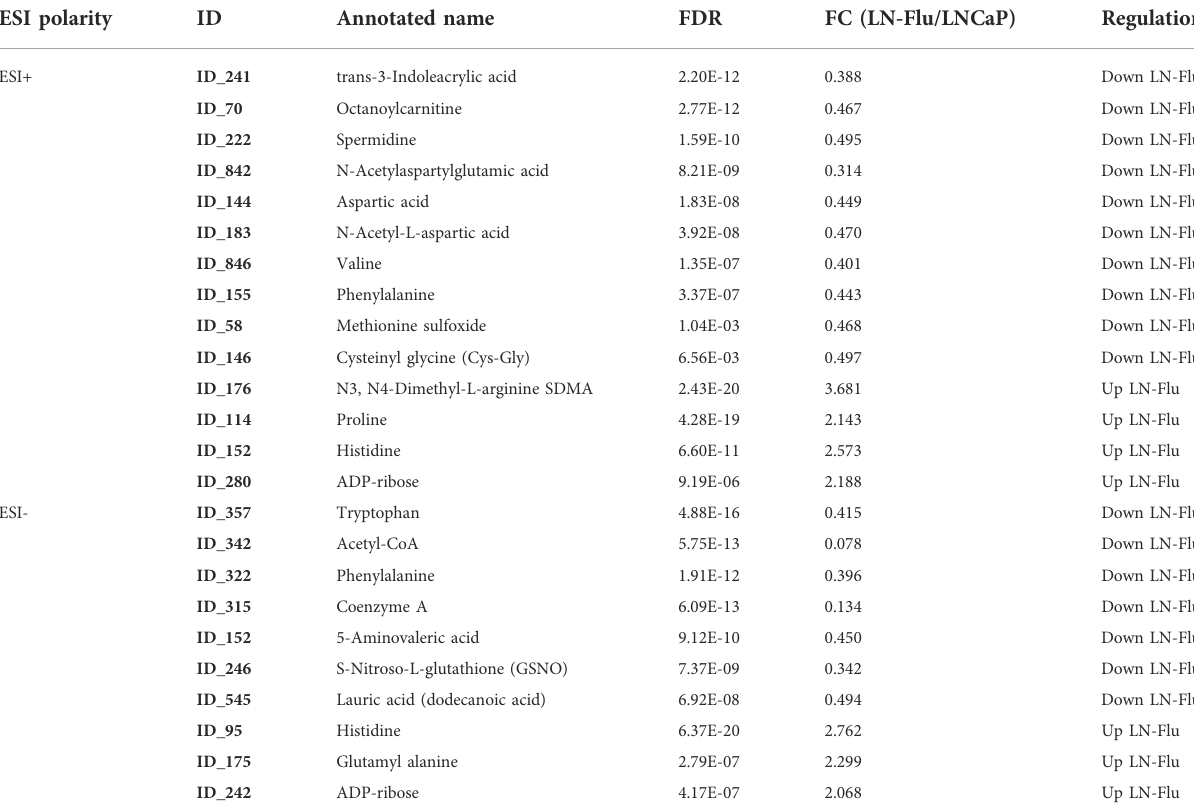
TABLE 1 Signi fi cant metabolites (FDR < 0.05 and FC > 2 or FC < 1/2) unequivocally identi fi ed.